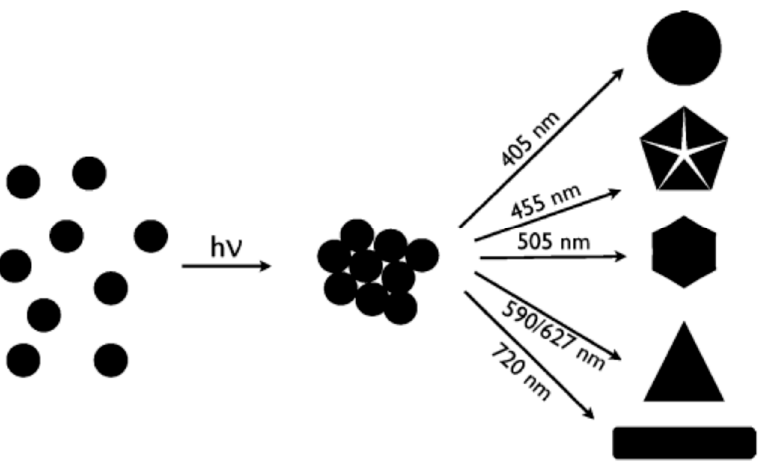
Figure 7. Different shapes obtained by irradiating very small Ag seeds by different wavelengths. Reprinted with permission from ref. [34]. Copyright (2010) American Chemical Society.